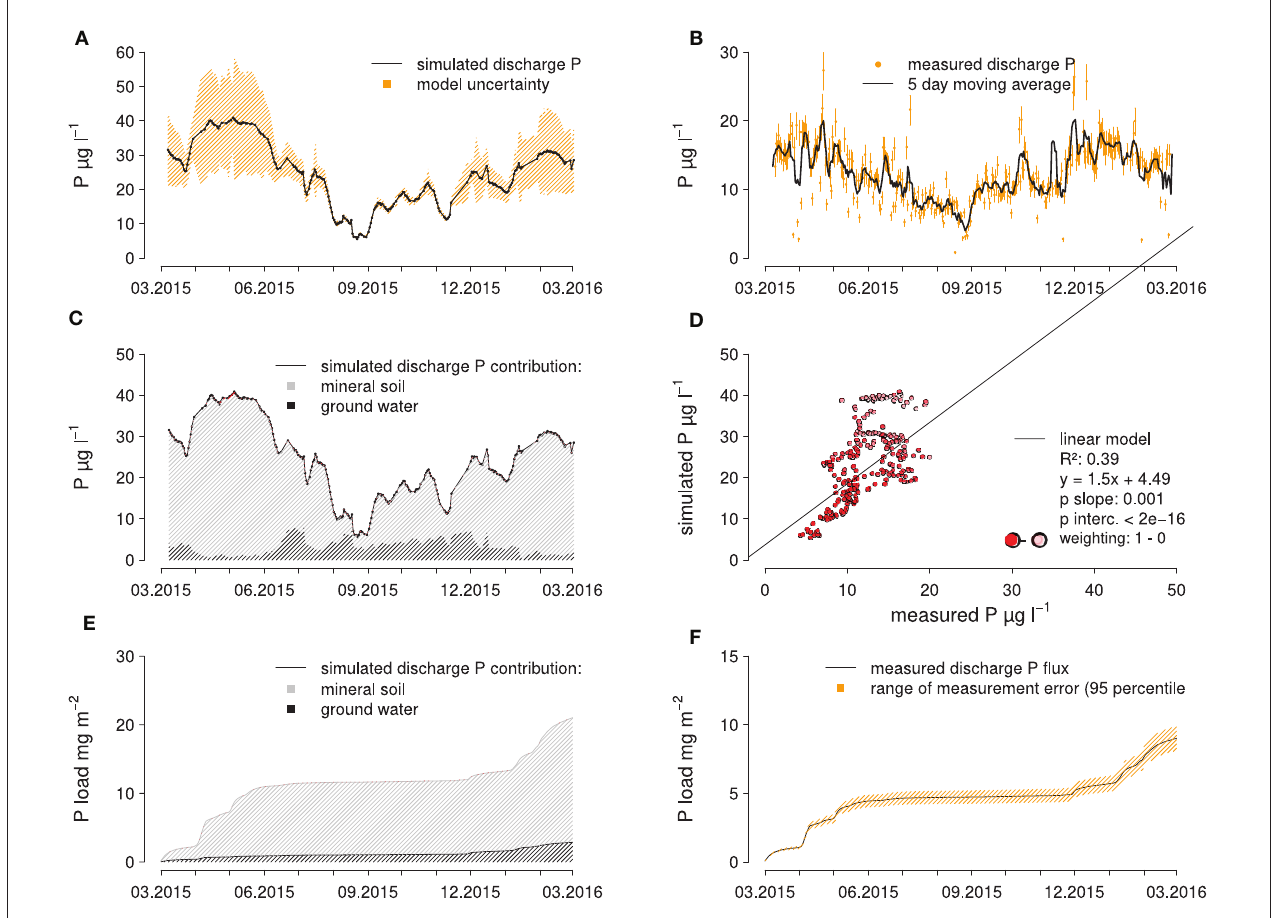
FIGURE 4 | Results of EMMA compared to measured data: simulated (A) and measured (B) discharge P concentrations, contribution of end members to simulated discharge P concentrations (C) , scatter plot of measured vs. simulated discharge P concentrations (D) , as well as simulated (E) , and measured (F) cumulative P fluxes in the creek